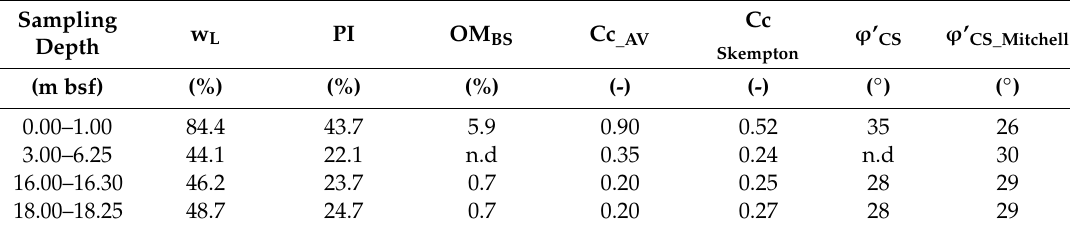
Table 5. Summary of the measured properties and those computed as function of soil plasticity. Key: w L , liquid limit; PI, plasticity index; OM BS , organic matter; Cc _AV , measured average compressibility for the layer; Cc_ Skempton , compressibility computed by Equation (4); ϕ ’ CS , critical state friction angle; ϕ ’ CS_Mitchell , critical state friction angle computed by Equation